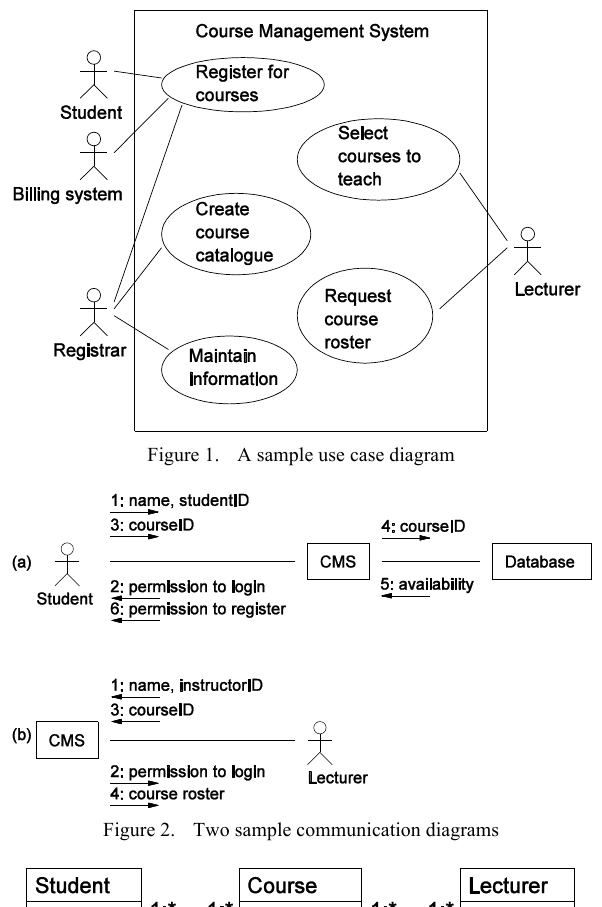
Figure 2. Two sample communication diagrams